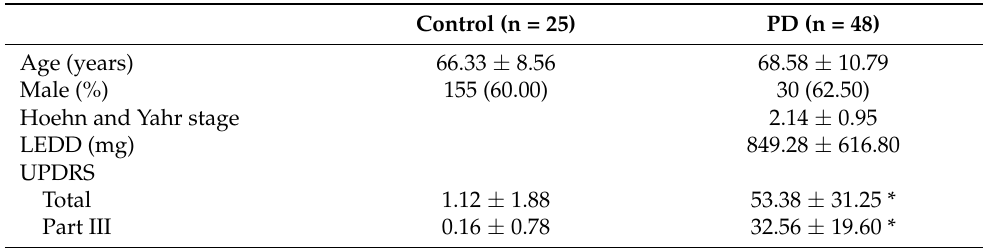
Table 1. Clinical characteristics of the discovery cohort.